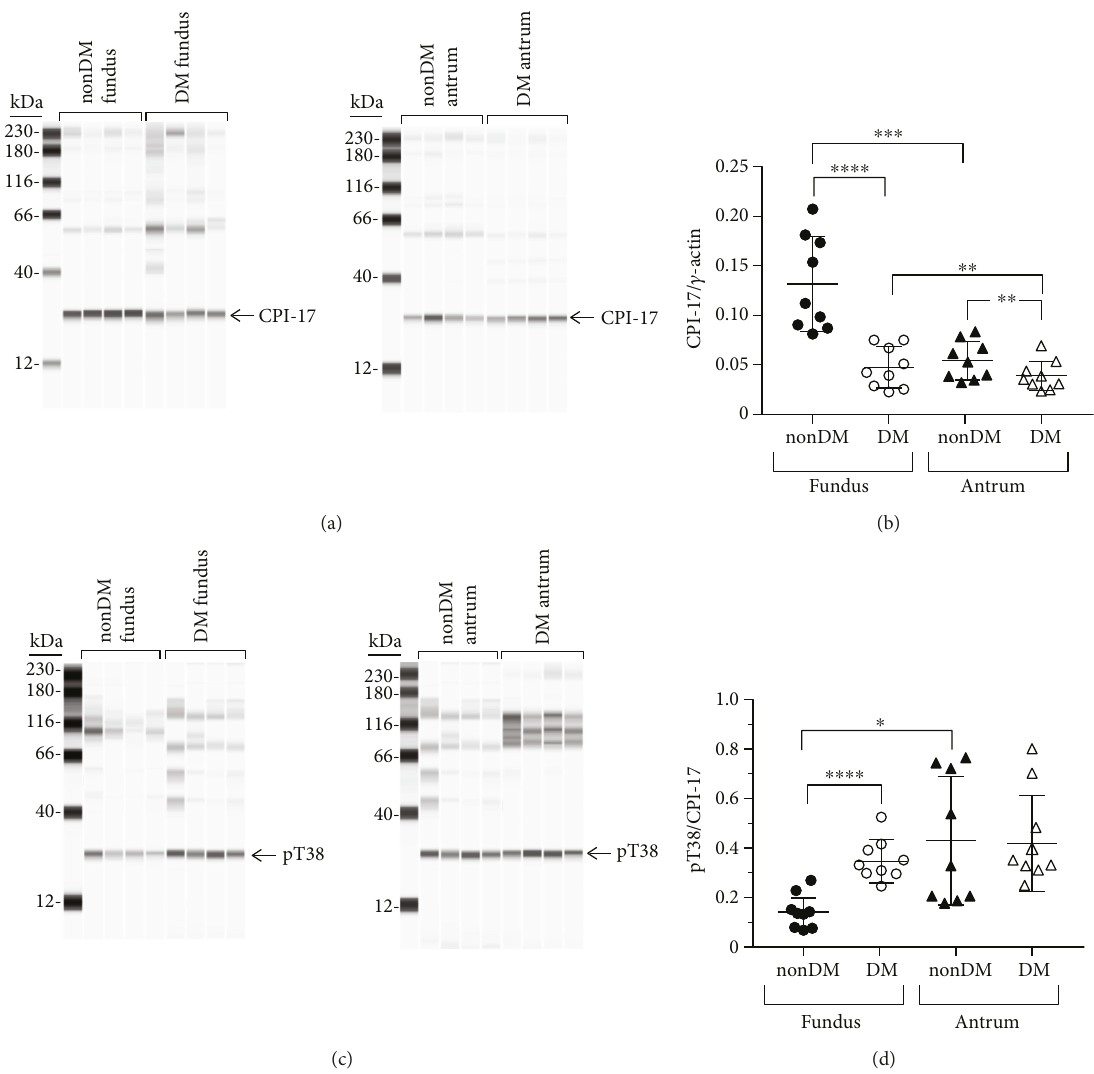
Figure 4: CPI-17 expression and T38 phosphorylation in nondiabetic and diabetic gastric fundus and antrum smooth muscles. (a) Representative immunoblots of CPI-17 expression in nondiabetic and diabetic fundus (left panel, n = 4 , each group) and nondiabetic and diabetic antrum muscles (right panel, n = 4 , each group), 1 μ g muscle lysate per lane. (b) CPI-17 expression relative to enteric γ -actin expression in nondiabetic and diabetic fundus and antrum smooth muscles. (c) Representative immunoblots of phosphorylated T38 in nondiabetic and diabetic fundus (left panel, n = 4 , each group) and nondiabetic and diabetic antrum muscles (right panel, n = 4 , each group), 1 μ g muscle lysate per lane. (d) T38 phosphorylation relative to CPI-17 expression in nondiabetic and diabetic gastric fundus and gastric antrum smooth muscles. ∗ P < 0 05 , ∗∗ P < 0 01 , ∗∗∗ P < 0 001 , and ∗∗∗∗ P < 0 0001